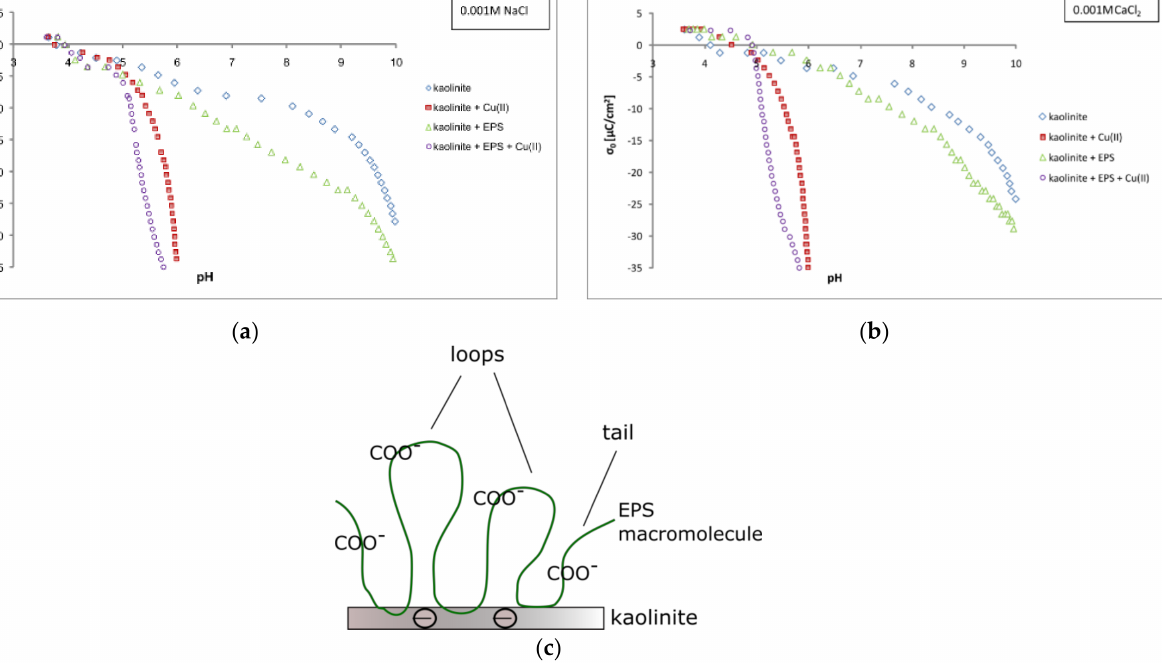
Figure 5. Surface charge density ( σ 0 ) of kaolinite in the absence and presence of Cu(II) ions and/or EPS (100 mg/L) in 0.001 M NaCl ( a ) and 0.001M CaCl 2 ( b ) as well as structures of EPS macromolecules on the kaolinite surface at pH 5 ( c